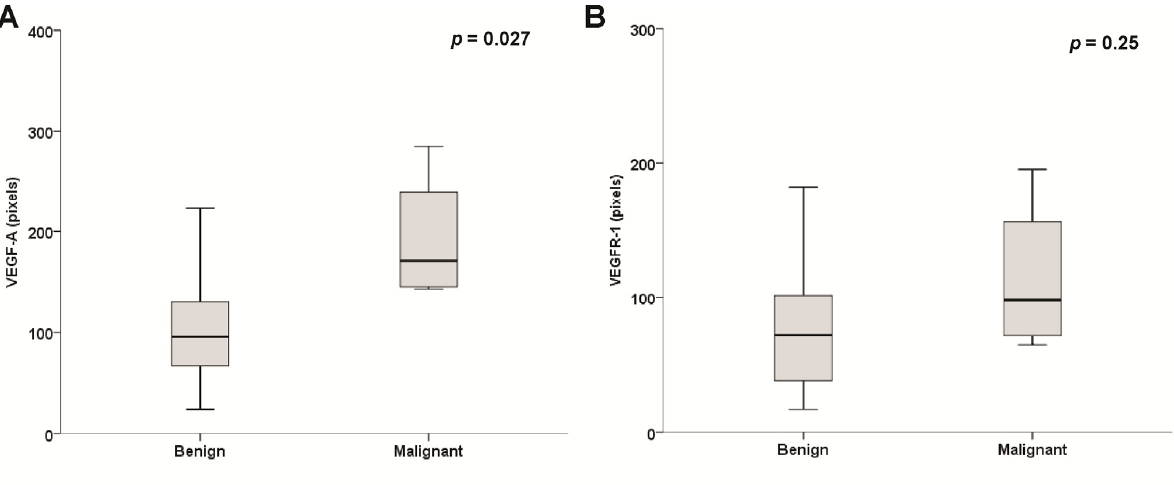
Figure 2. Immunohistochemical intensity of ( A ) VEGF-A; ( B ) VEGFR-1; ( C ) VEGFR-2; and ( D ) MVD in benign and malignant PHEO